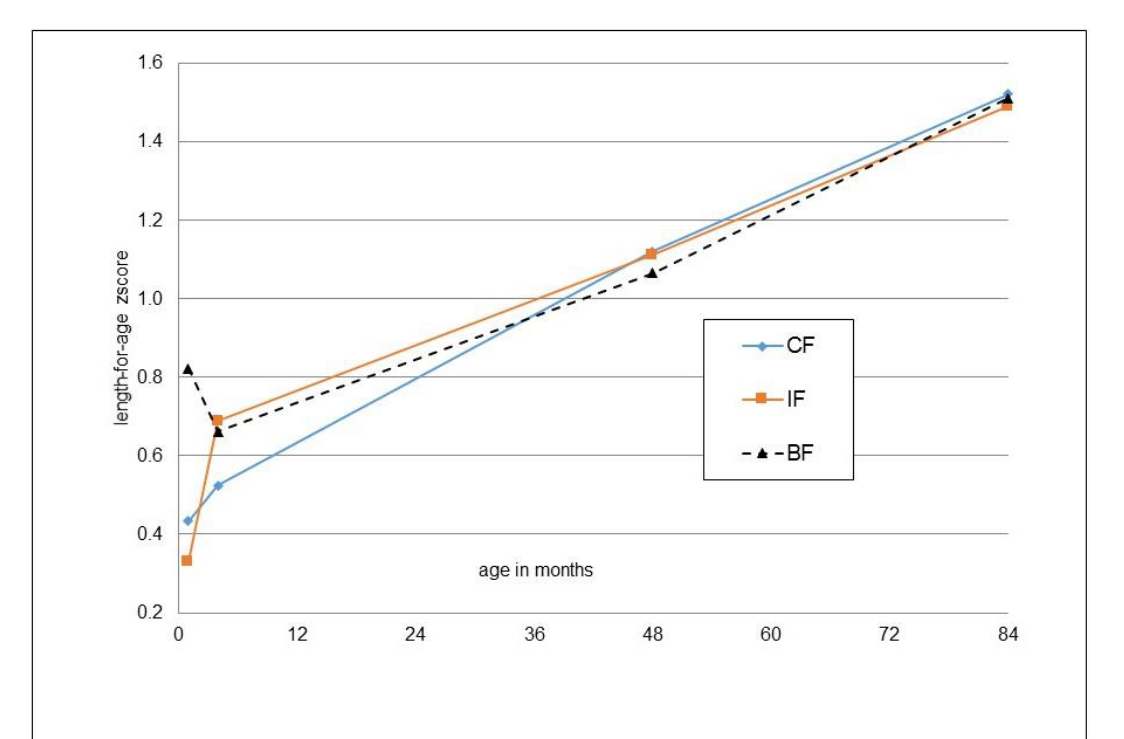
Figure 2. Mean z-scores for weight-for-age at one month (IF: n = 50, CF: n = 54, BF: n = 57), four months ( n = 50, n = 54, n = 57), four years ( n = 48, n = 52, n = 57) and seven years ( n = 50, n = 54, n = 57) for those children participating in the 7-year follow-up; * significant difference between IF and CF, t -test.